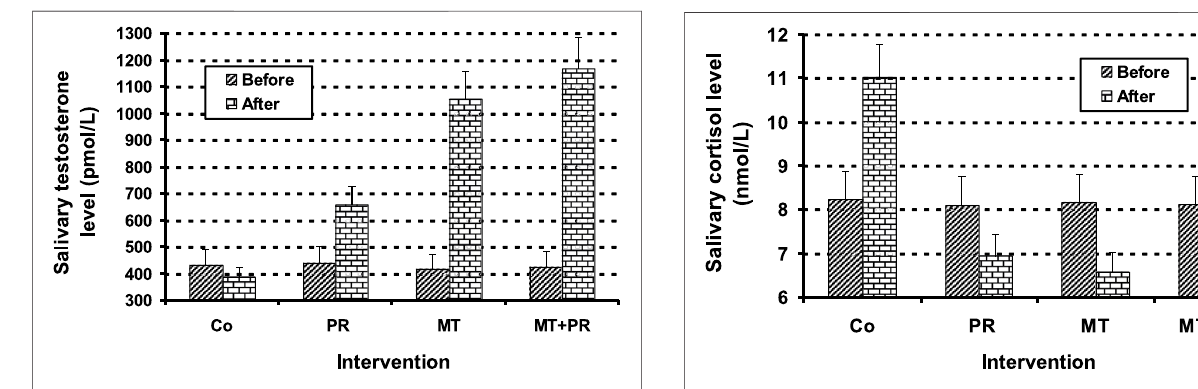
Frontiers in Physiology |